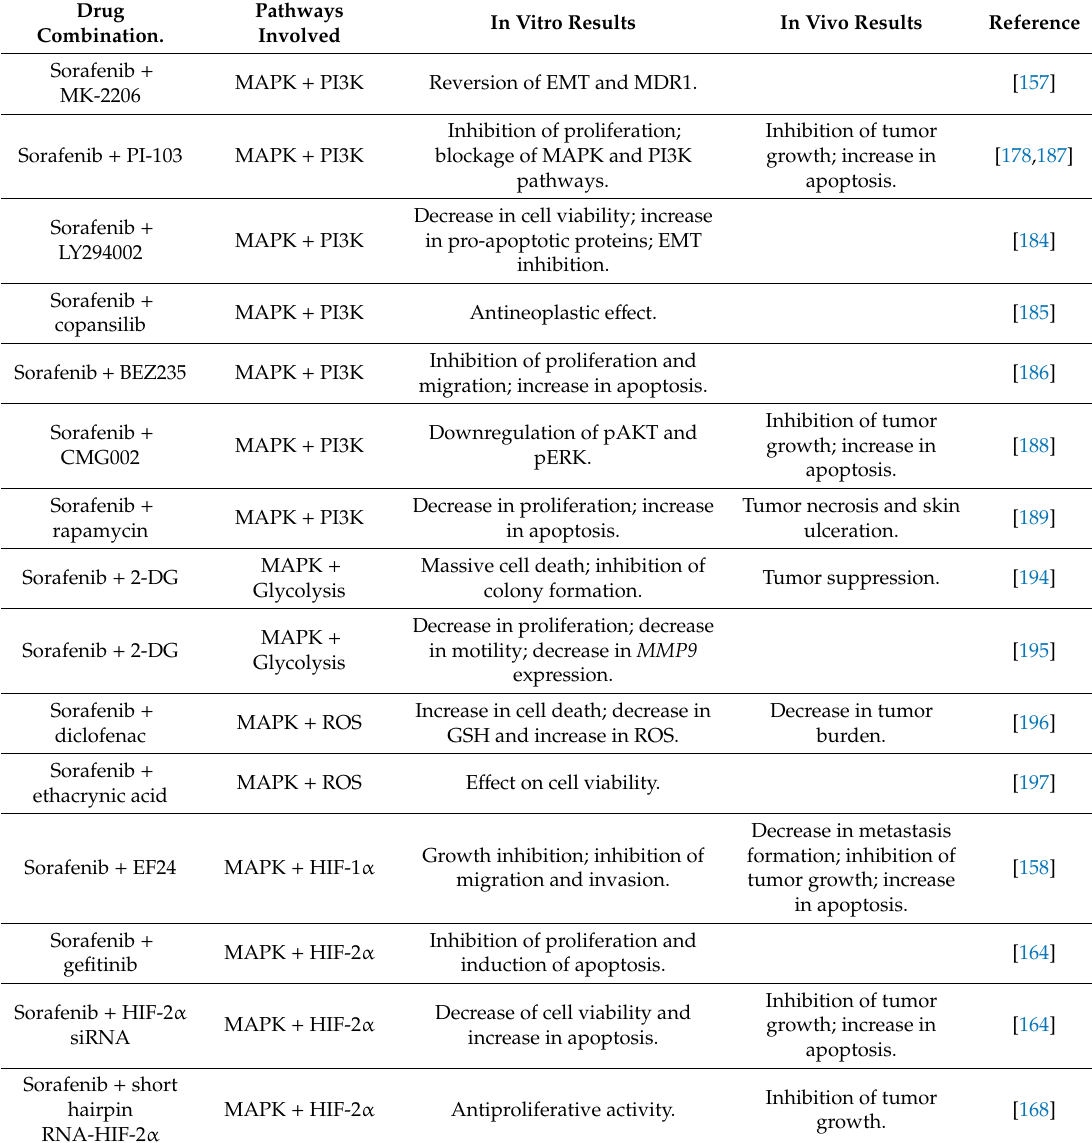
Table 1. Treatment combinations tested in vitro in HCC cell lines and in vivo in HCC animal models. Drug